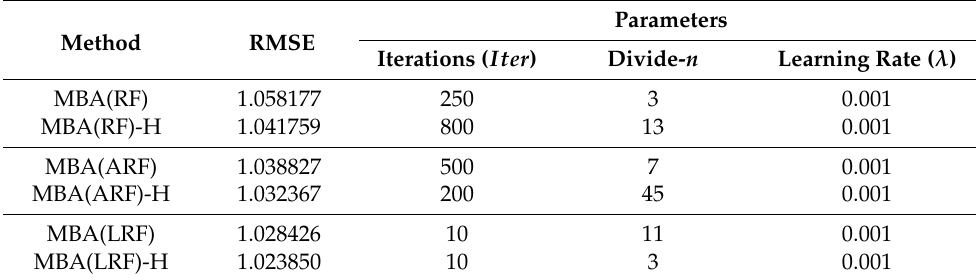
Table 4. Comparison of results (Heuristics